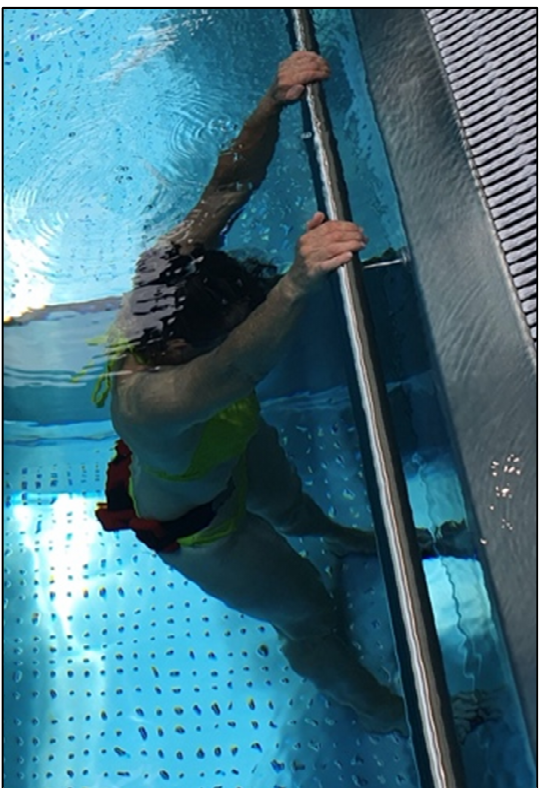
Figure 1. Passive motion of the shoulder (aquatic therapy).